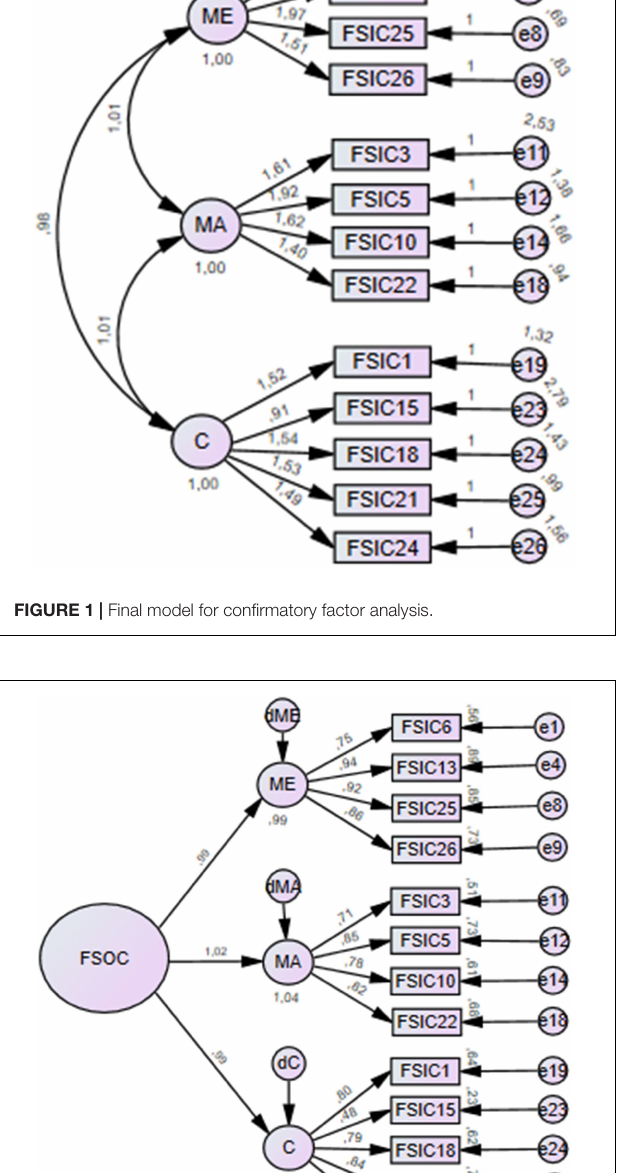
of a second-order factor increased the covariance value for the MA